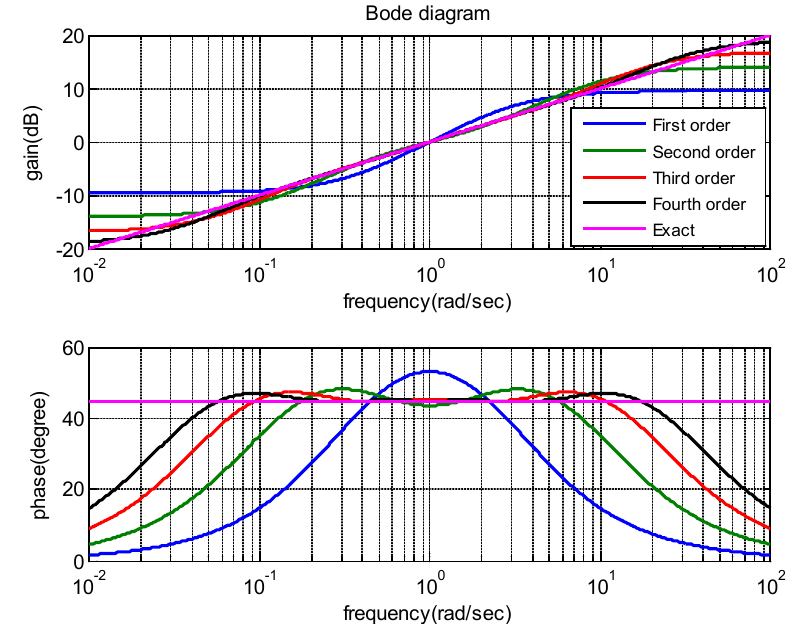
Figure 4. Step responses for order approximations given in Equations